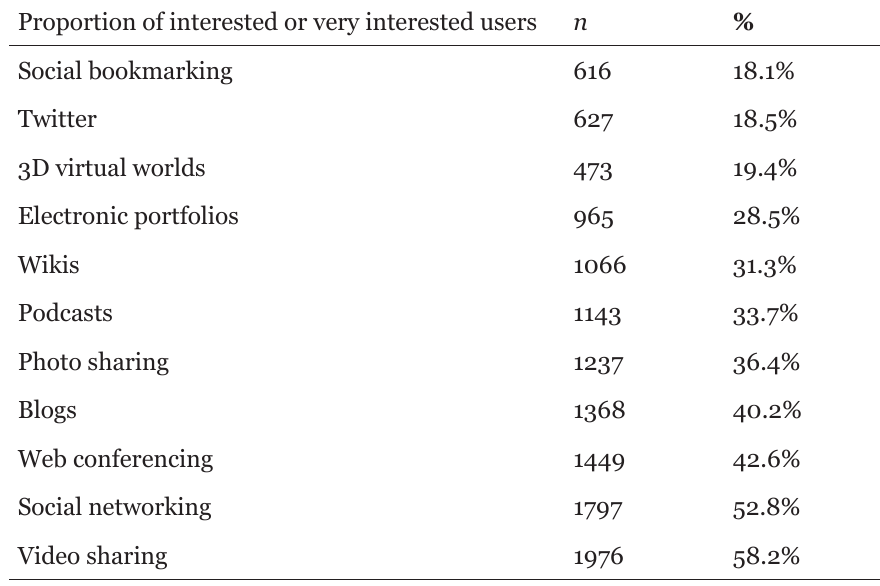
Interest in Using Social Software for Learning Purposes Proportion of interested or very interested